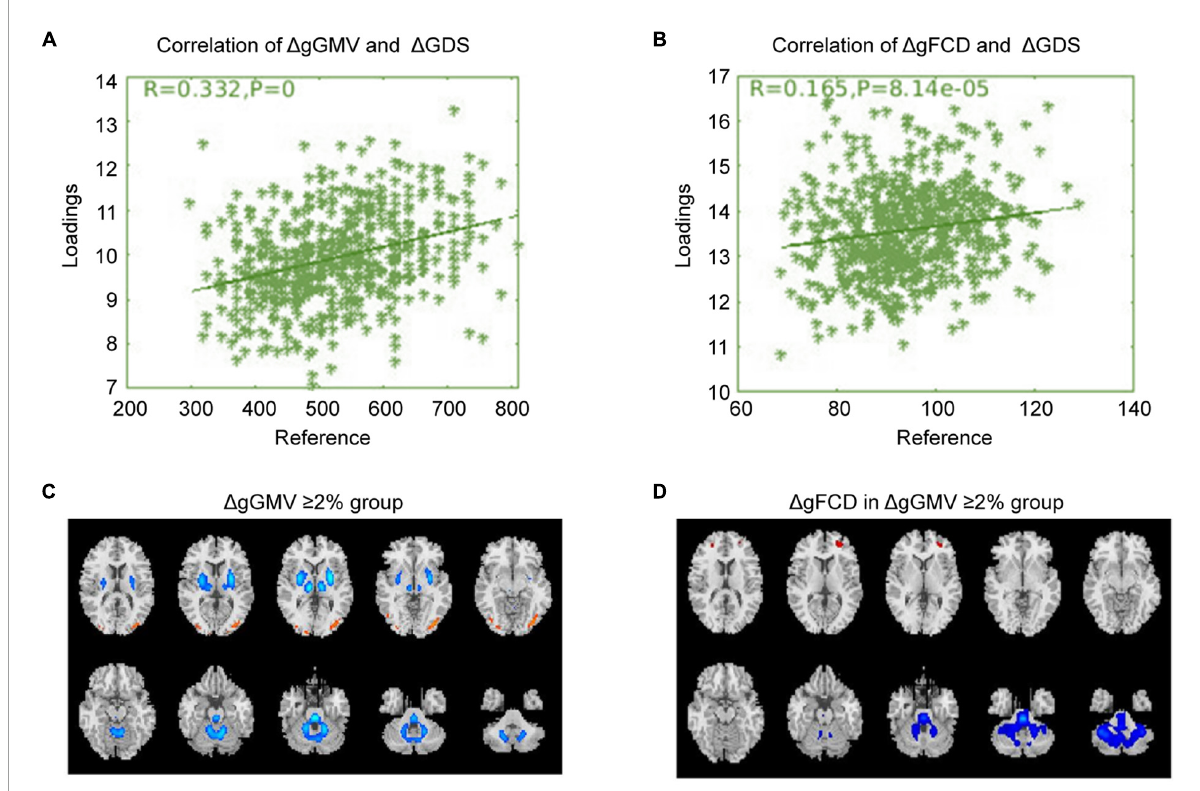
FIGURE3 The correlation between baseline (cid:49) gGMV/ (cid:49) gFCD and cognitive deterioration in the severe whole-brain alteration group. Based on (cid:49) gGMV at baseline, schizophrenia patients were divided into three different severity groups: mild, moderate, and severe brain alteration groups. Correlation analysis was conducted to examine the relationship between subsequent cognitive deterioration after two years of treatment and baseline (cid:49) gGMV/ (cid:49) gFCD in the drug-naïve first-episode schizophrenia with baseline (cid:49) gGMV ≥ 2% in the severe whole-brain alteration group. (A) Relationship between (cid:49) gGMV and (cid:49) GDS; (B) Relationship between (cid:49) gFCD and (cid:49) GDS; (C) The severe whole-brain alteration group with (cid:49) gGMV ≥ 2% at baseline; (D) (cid:49) gFCD in the severe whole-brain alteration group.